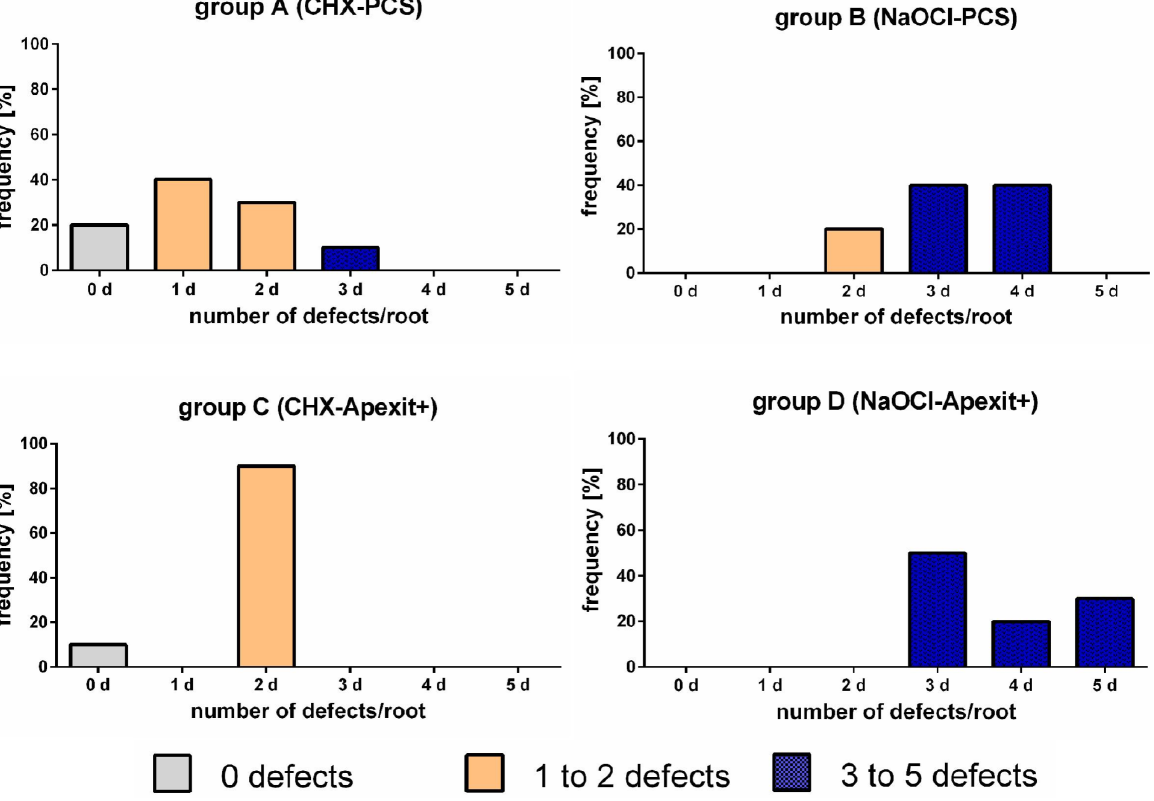
Figure 4. Frequency of endodontically treated roots with zero to five coexisting defects in each